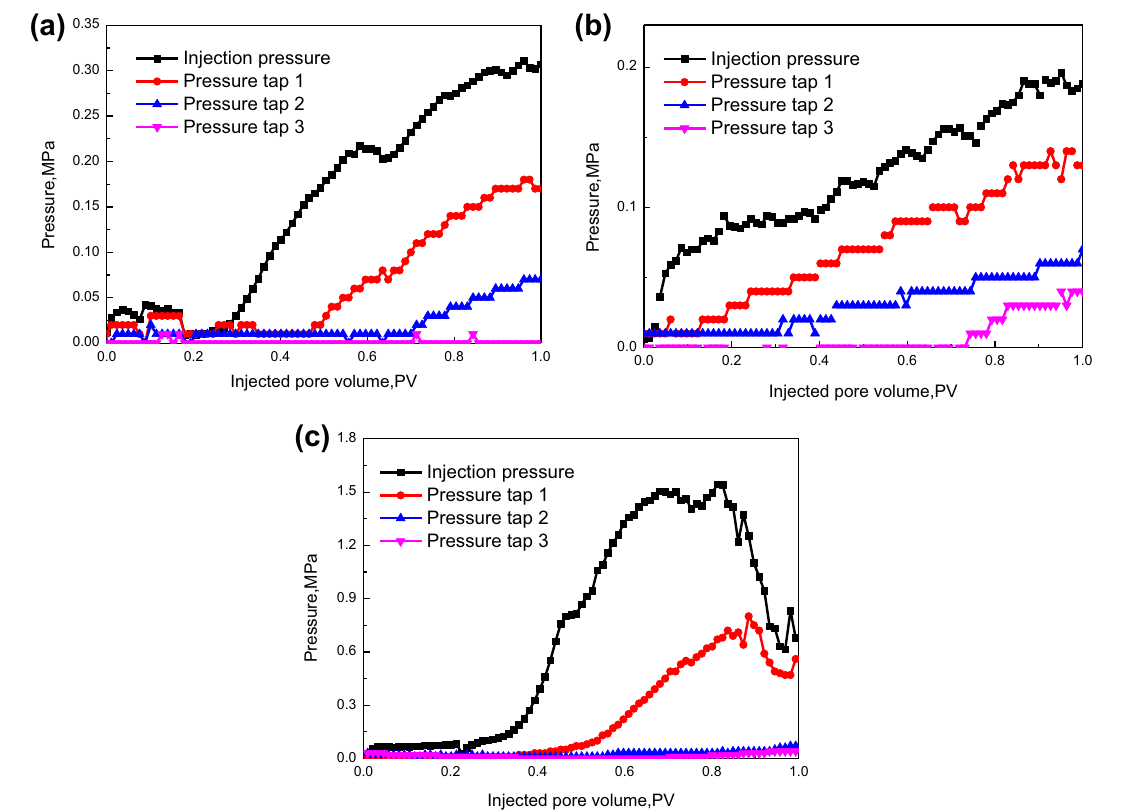
Fig. 11 Injection pressure, pressure of tap 1, pressure of tap 2, and pressure of tap 3 plotted as a function of injected volume of sam- ples: a 0.2% linear polymer, b 0.2% surfactant–polymer, and c